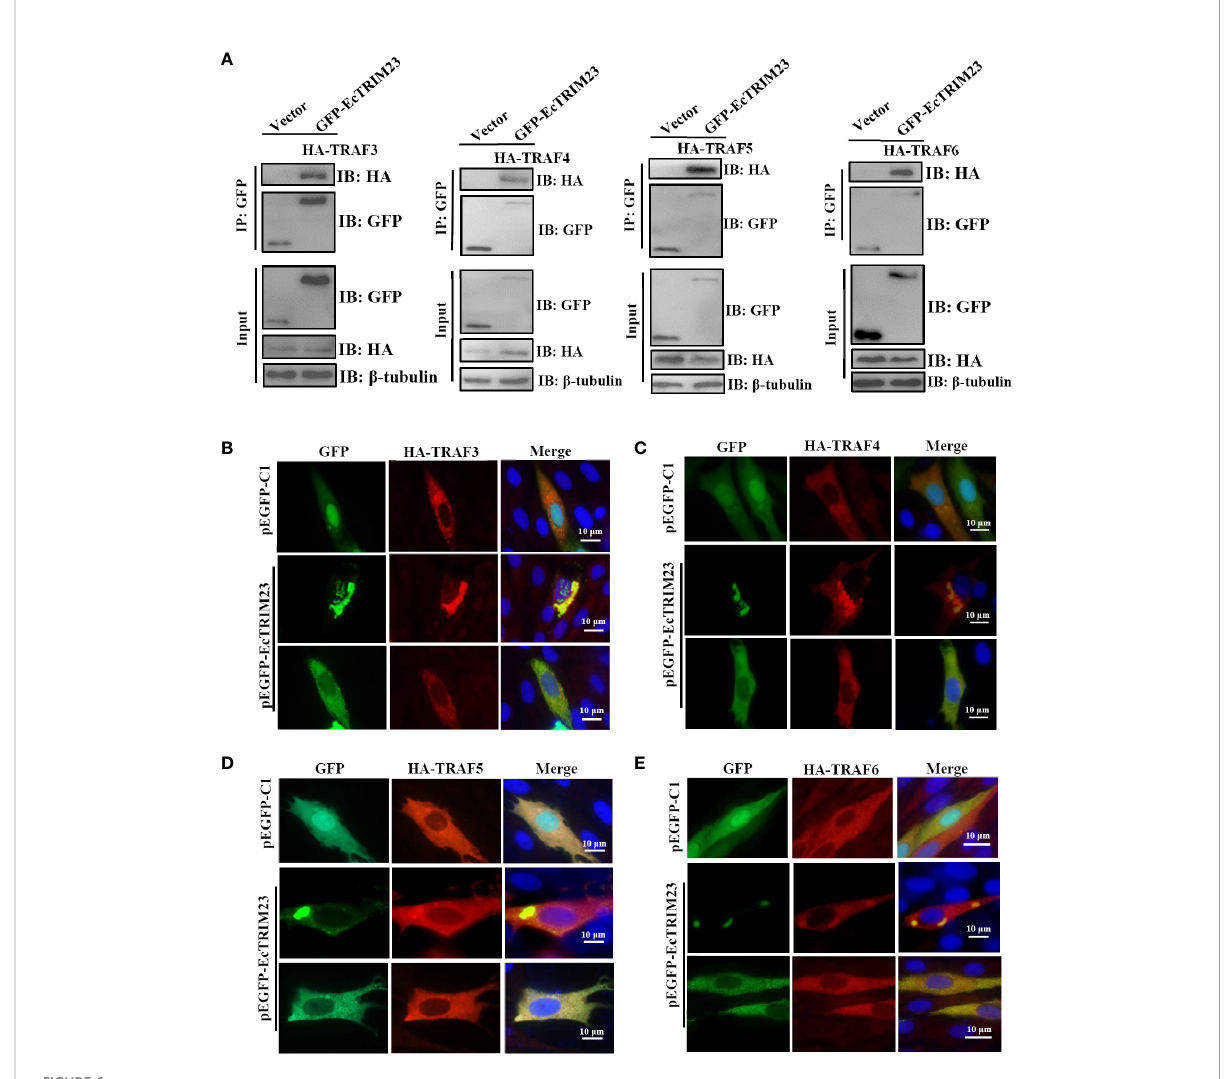
FIGURE 6 EcTRIM23 interacted with EcTRAFs in grouper cells. (A) EcTRIM23 interacted with EcTRAFs, including EcTRAF3, EcTRAF4, EcTRAF5 and EcTRAF6. GS cells were co-transfected with pEGFP-EcTRIM23 or pEGFP-C1 and HA-EcTRAFs for 48 h. After immunoprecipitation with GFP antibody, immunoblotting was carried out using anti-GFP and anti-HA antibodies (Abs), respectively. EcTRIM23 colocalized with different TRAFs, including EcTRAF3 (B) , EcTRAF4 (C) , EcTRAF5 (D) and EcTRAF6 (E) . GS cells were co-transfected with pEGFP-EcTRIM23 and HA-EcTRAFs (HA- EcTRAF3, HA-EcTRAF4, HA-EcTRAF5 and HA-EcTRAF6) for 48 h, and then fi xed for IFA